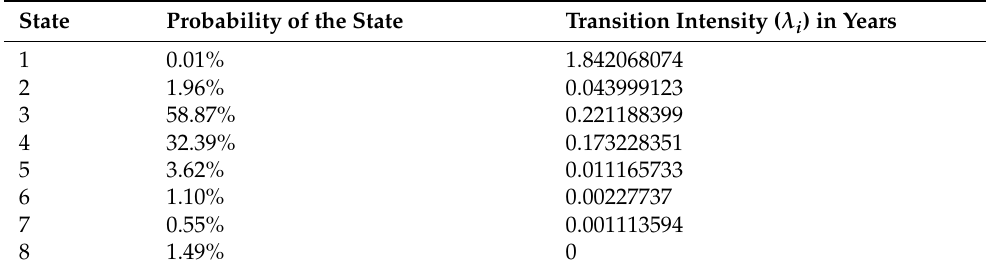
Table 1. State probability and transition intensity (modified from the source: Heidarydashtarjandi, Prasad-Rao, and Groth [6])).